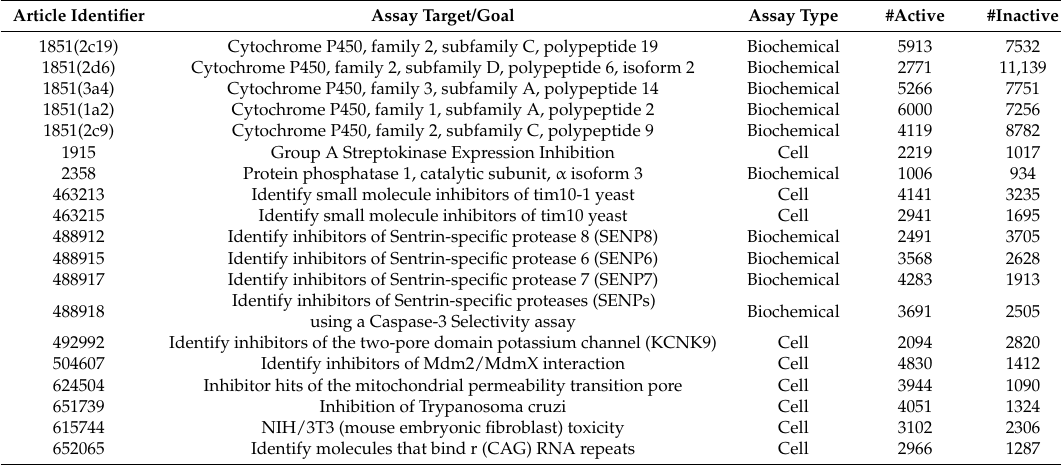
Table 4. List of assays from Pubchem that were used for the study of Dahl et al.